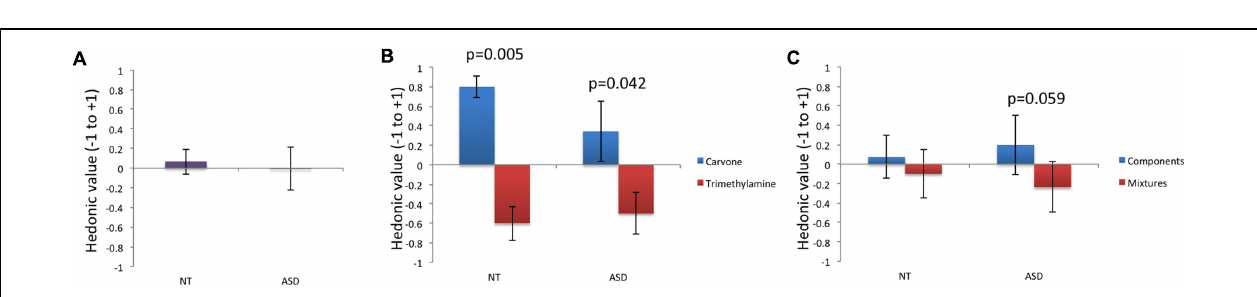
FIGURE 2 | Odor pleasantness. For odor pleasantness ratings, no difference was observed between groups when considerign all odors (A) . A significant effect of valence was observed in the NT group: the smell of Carvone was perceived as significantly more pleasant than the smell of Trimethylamine ( p = 0.005). A similar effect of valence was observed in the ASD group, although the magnitude of the effect was lower ( p = 0.042) (B) . It noteworthy that a trend toward lower pleasantness of odor mixtures than the individual components was observed in the ASD group ( p = 0.059) (C)